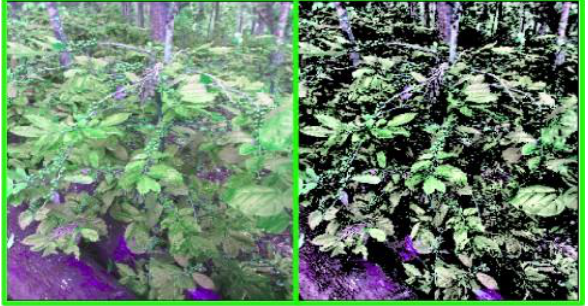
Figure 5. Healthy plants show bushy green stems and berries.